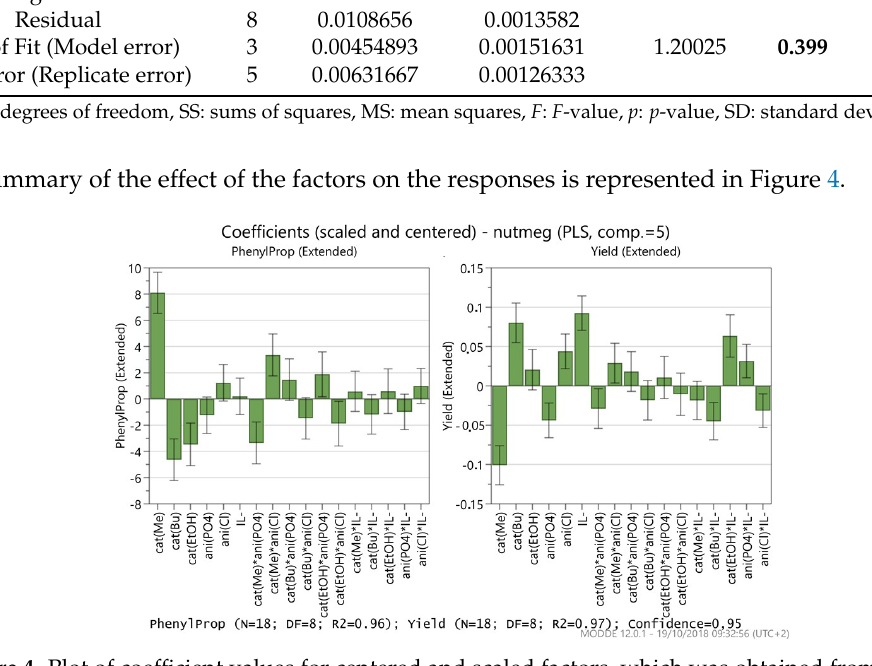
Table 2. ANOVA test for the model.